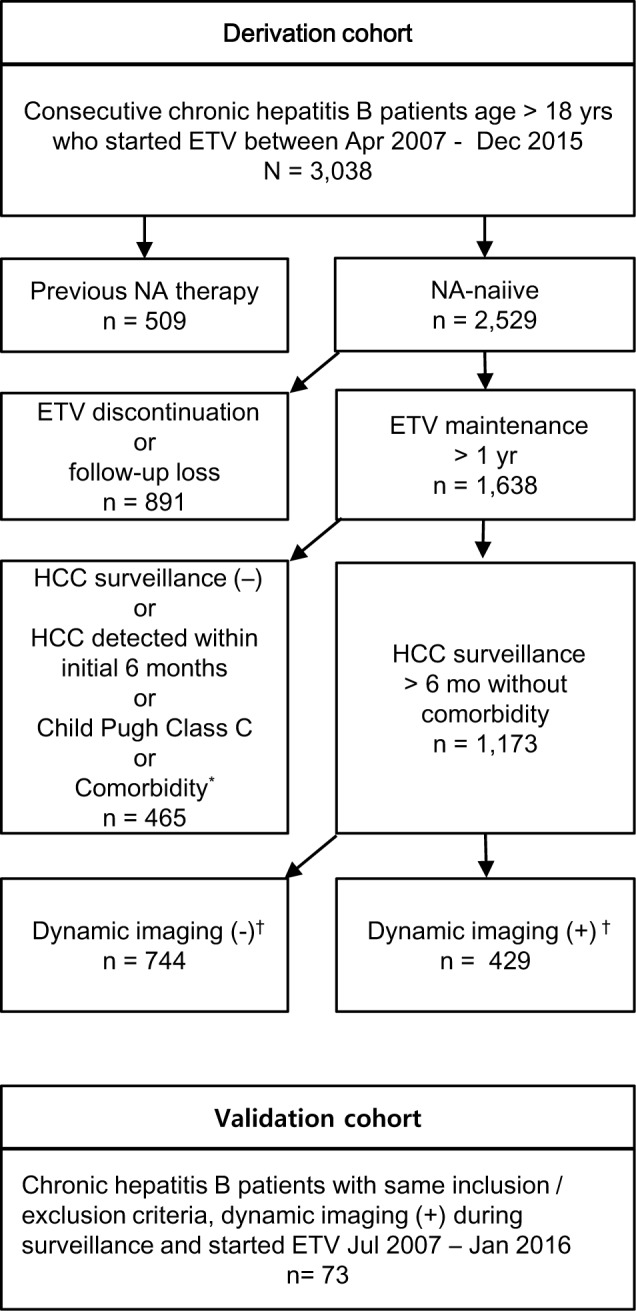
Flow chart of the study population.*HCV or HIV coinfection, other malignancy or organ transplantation. †Dynamic imaging (+) subgroup received at least one dynamic CT study during surveillance which revealed no evidence of HCC: this subgroup served as the derivation dataset for liver volume analysis. No dynamic imaging subgroup did not receive dynamic CT studies during surveillance, except for the confirmative imaging tests in case of HCC. ETV, entecavir; HCC, hepatocellular carcinoma; NA, nucleos(t)ide analogue.